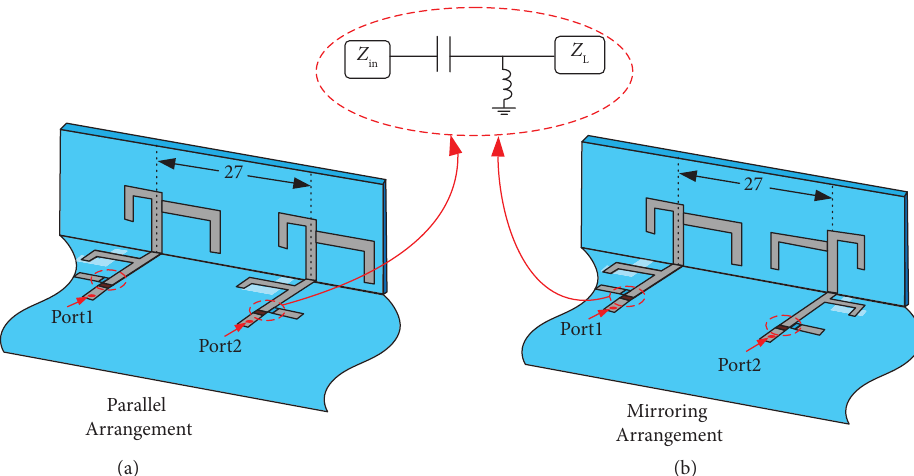
Figure 5: Arrangement of antenna elements: (a) parallel arrangement; (b) mirroring